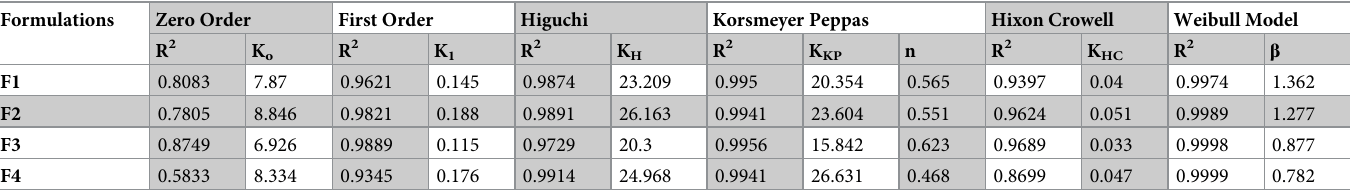
Table 6. Invitro kinetic models of propranolol HCl floating tablets. Formulations Zero Order